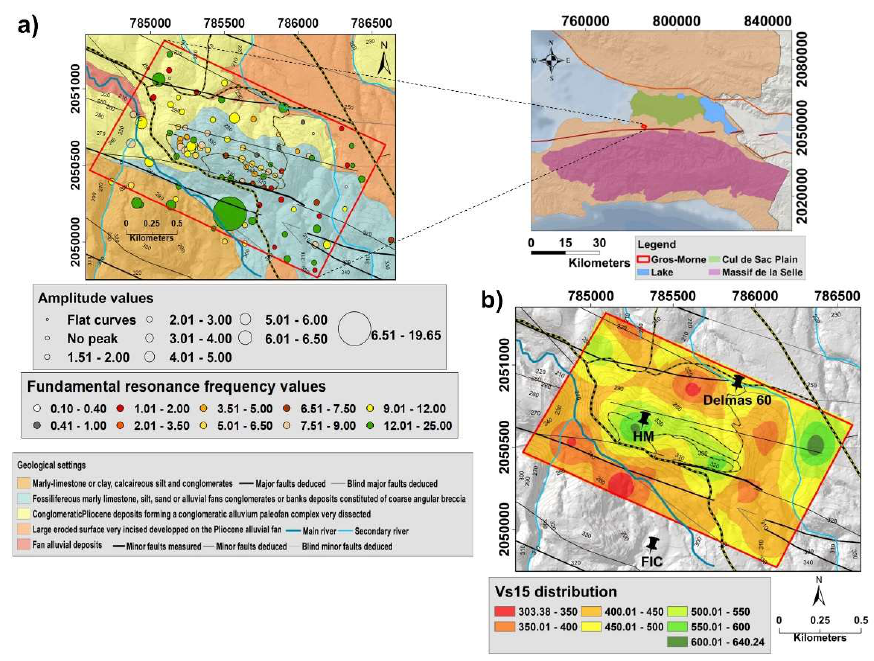
Figure 1. ( a ) Distribution of the horizontal to vertical spectral ratio (HVSR) results on the geological map (see on the right the location on larger general geological map); the size of the circle indicates the amplitude level. The circle color represents the f0 values. ( b ) Distribution map of shear wave velocity over the first 15 m of depth with locations of the seismic stations at Hotel Montana (HM), Delmas 60, and at FIC.